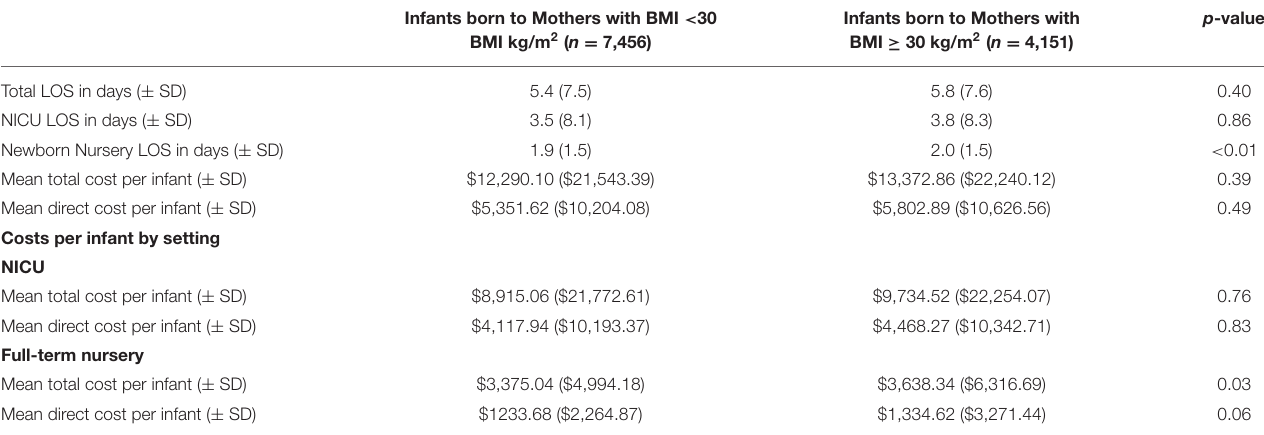
TABLE 3 | Length of stay (LOS) and cost characteristics of infants born to mothers without and with obesity after adjusting for smoking status, pre-pregnancy diabetes, gestational diabetes, pre-pregnancy hypertension, gestational hypertension. Infants born to Mothers with BMI < 30 Infants born to Mothers with BMI kg/m 2 ( n = 7,456) BMI ≥ 30 kg/m 2 ( n =